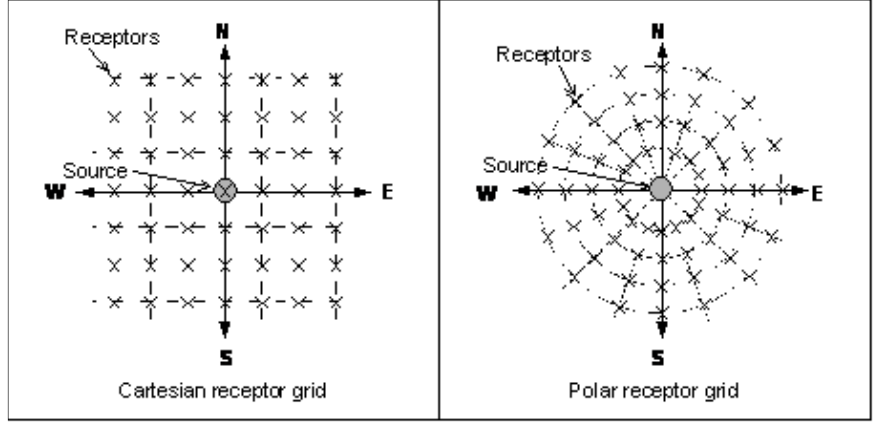
Figure 9. Polar and cartesian grids representing how the receptors are placed in the space around the source.